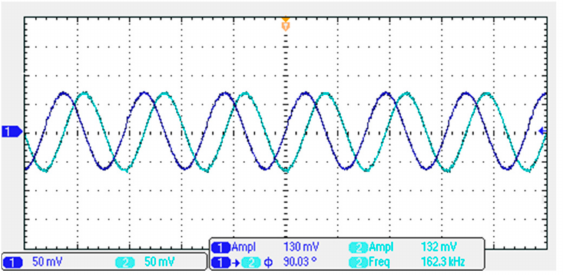
Figure 20. The measured waveforms of the quadrature voltage outputs V o1 and V o2 in the time domain.